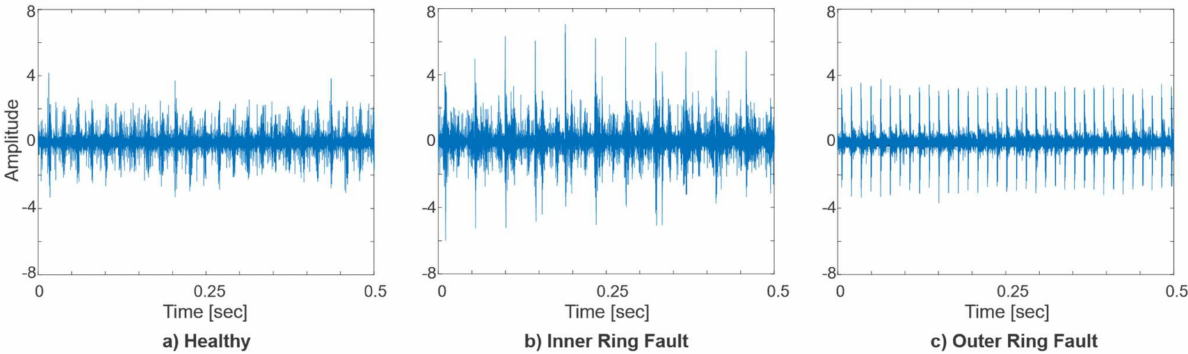
Figure 6. Time-domain raw vibration signal plots of: ( a ) Healthy bearing; ( b ) Bearing with inner ring fault; ( c ) Bearing with outer ring